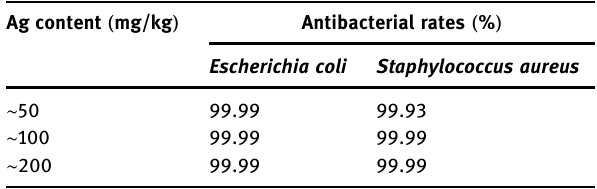
Table 1: Antibacterial rates of the treated polyester fi bers Ag content ( mg/kg